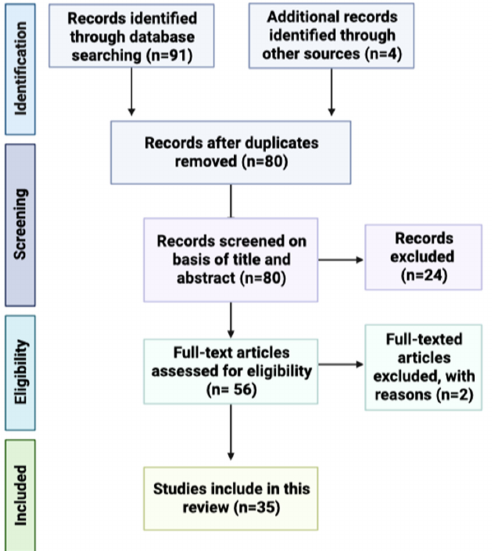
Figure 2. PRISMA flow diagram displaying the procedure of study selection.